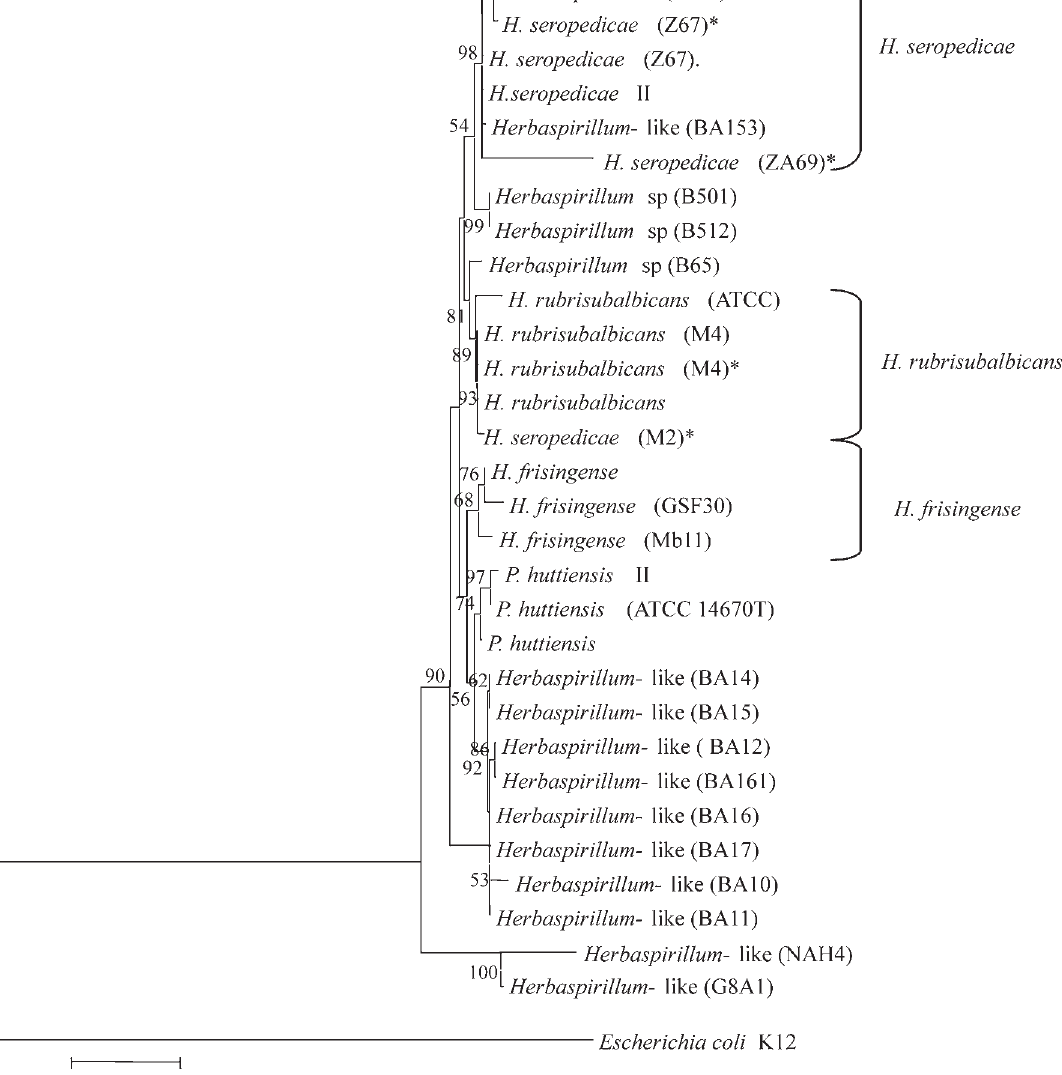
Figure3 -Phylogenetictreeinferredfrom16SrDNAsequencesof Herbaspirillum strainsobtainedinthiswork(*)oravailableintheGenBankdatabase, and representative beta-Proteobacteria. The tree was constructed by the neighbor-joining method. The boot-strap values were calculated from 2000 trees, and each number on a branch indicates the percentage of trees in which the node was supported. The bar represents the percentage of sequence diver-